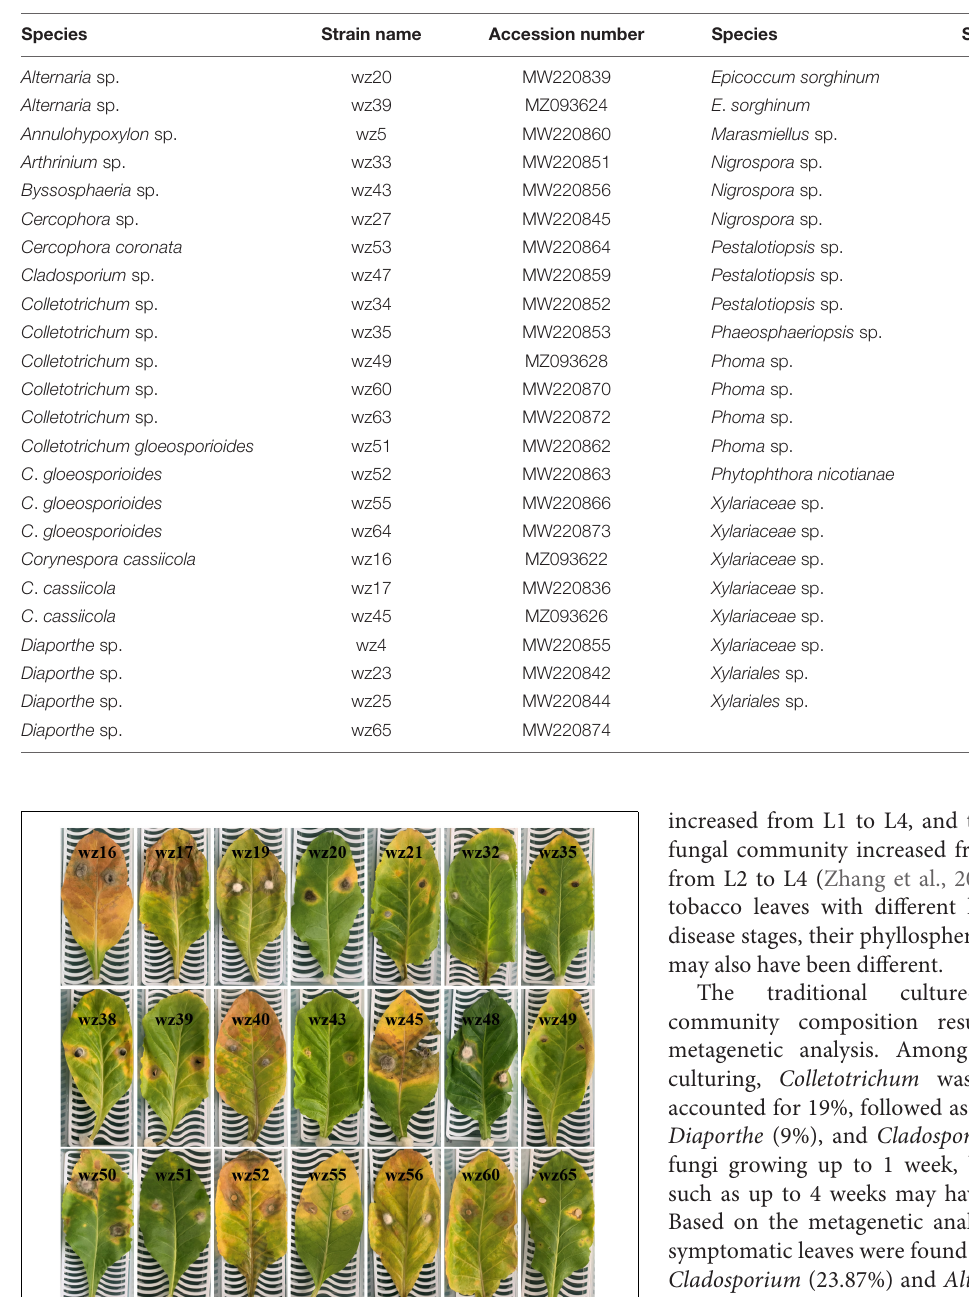
TABLE 4 | Fungi isolated from symptomatic leaves, and their identity based on ITS sequences, and their GenBank accession numbers.